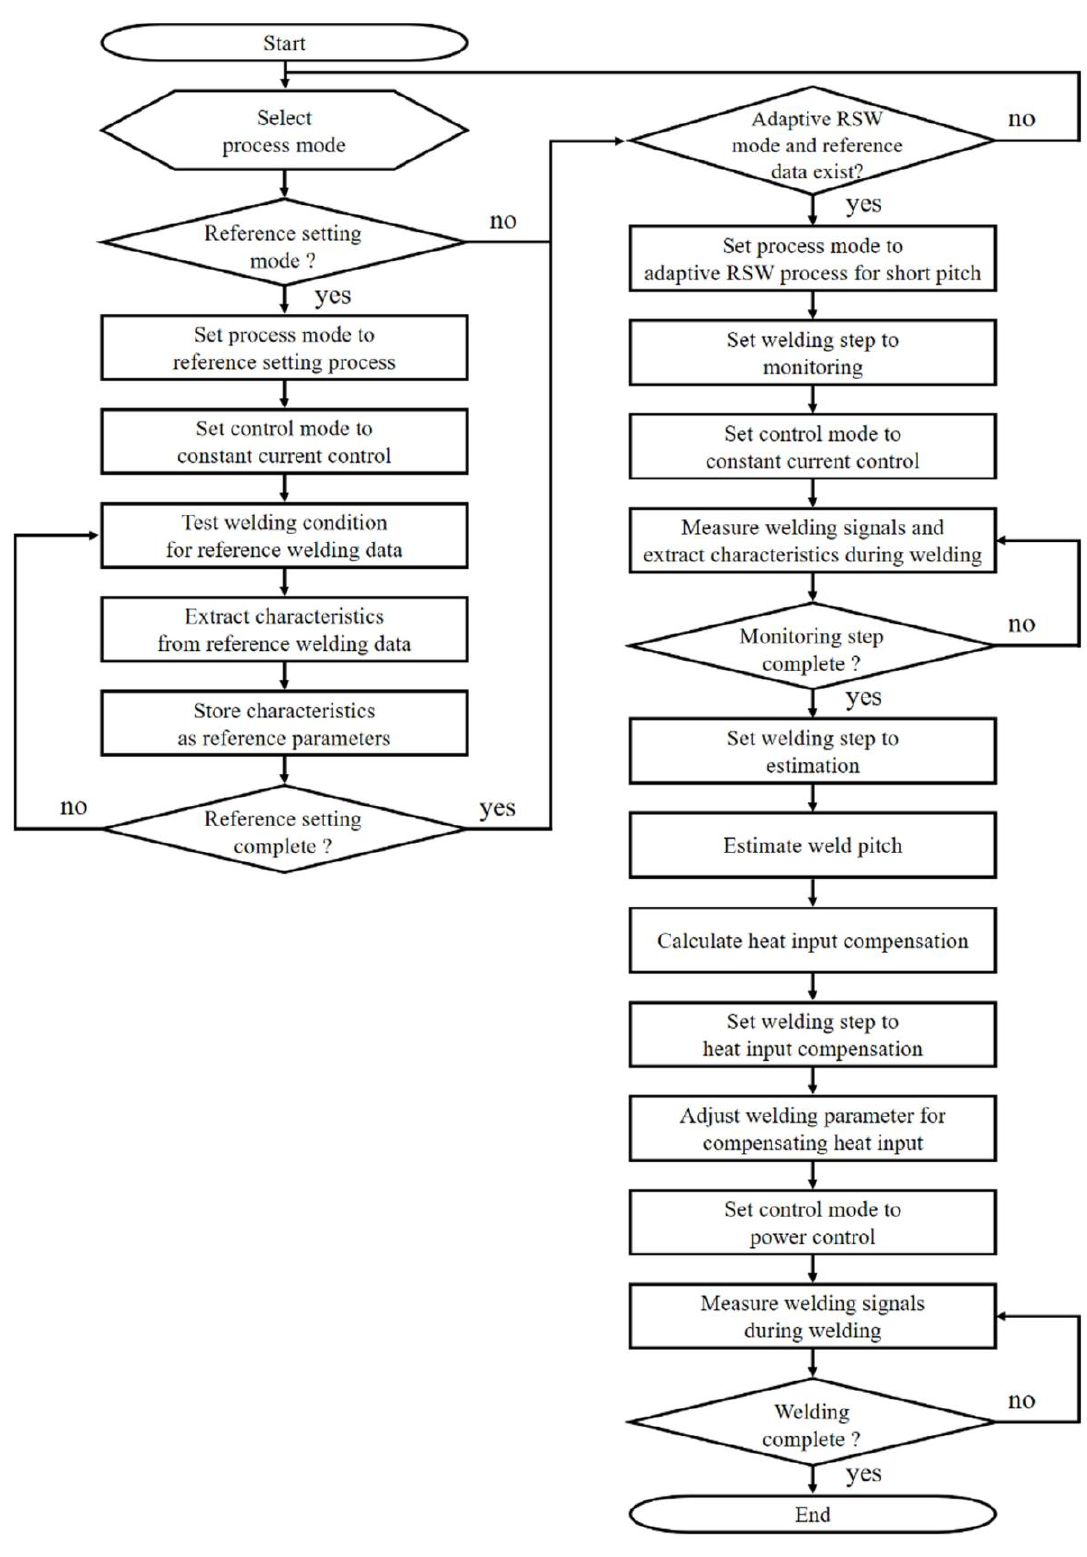
Figure 6. Proposed reference-based adaptive RSW method.